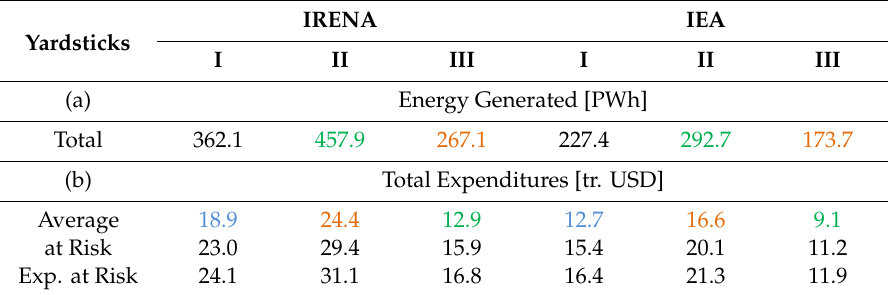
Table 2. Energy generated and capital